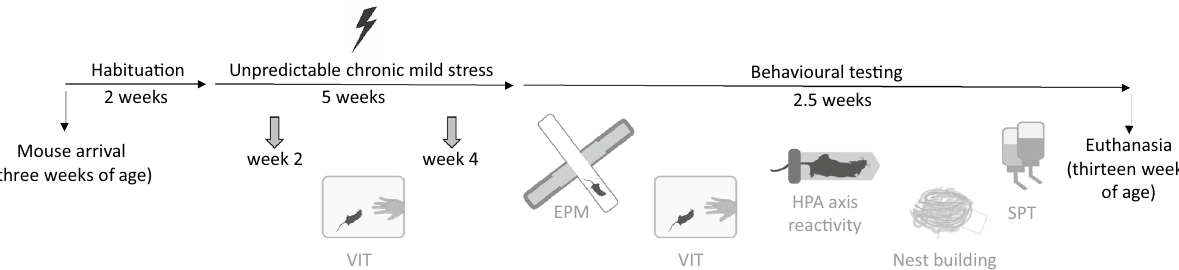
Figure 8. Timeline of Experiment 2. After habituation to the facility, the animals were handled twice weekly throughout the housing and testing period. Animals were tested for voluntary interaction (VIT) twice during the housing period and once after the elevated plus-maze (EPM) testing. In addition, animals were tested in the EPM, hypothalamic–pituitary–adrenal (HPA) axis reactivity after physical restraint, nest building and for anhedonia using a sucrose preference test (SPT). Mouse image reprinted from Scidraw doi.org/10.5281/ zenodo.3925917.